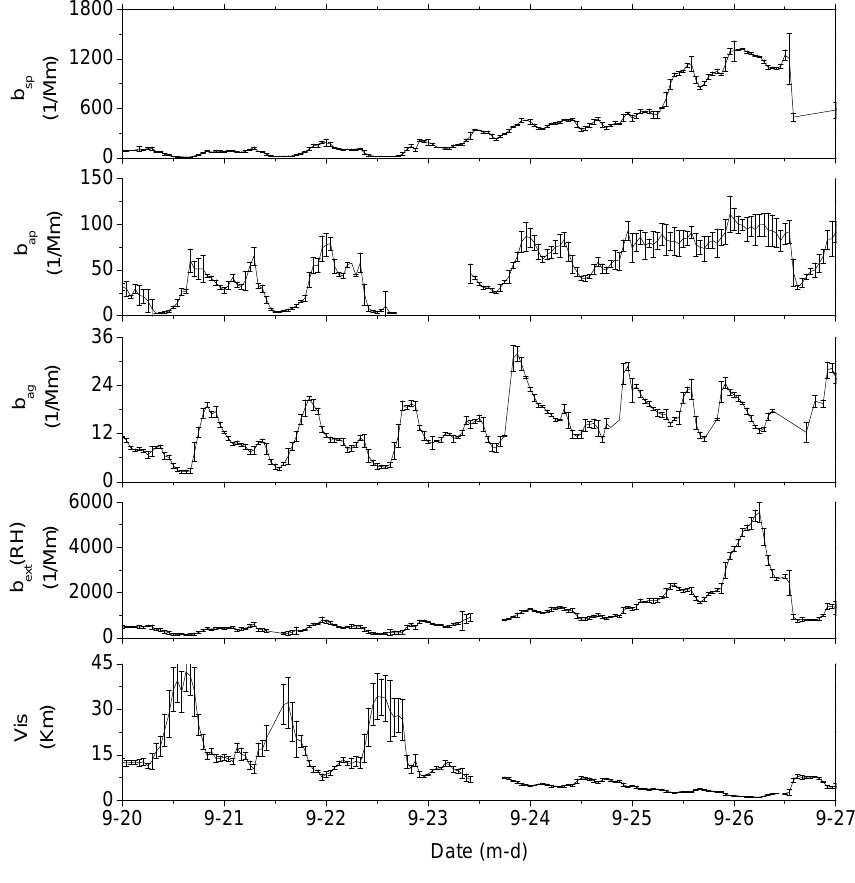
Fig. 2. Time series of measured aerosol scattering coefficient b sp , aerosol absorption coefficient b ap , absorption coefficient by NO 2 b ag , atmospheric extinction coefficient b ext (RH), and atmospheric visibility (Vis) in Beijing from 20–27 September 2011.